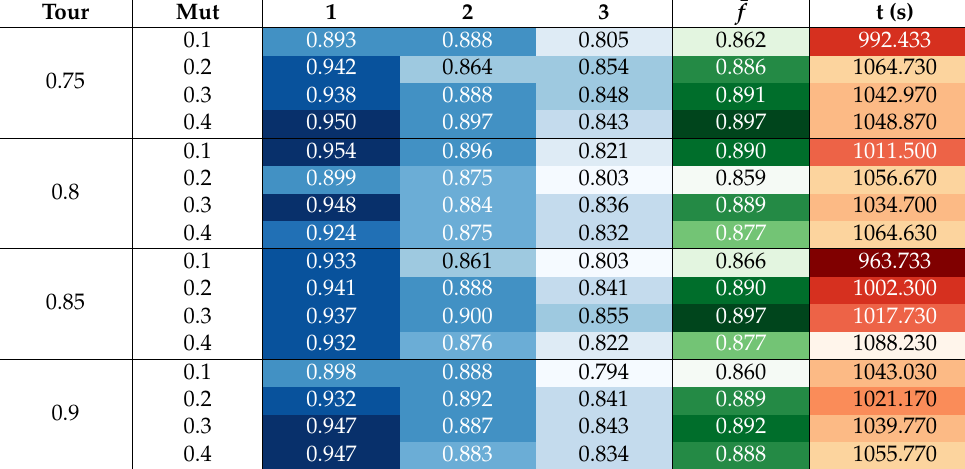
Table A3. Calibration results for map 751. Colored columns show fitness averages for each step (identified by step number), average over all steps ( ¯ f ), and runtimes (in seconds). Each row is a combination of two parameters: tournament probability (tour) and mutation rate (mut).